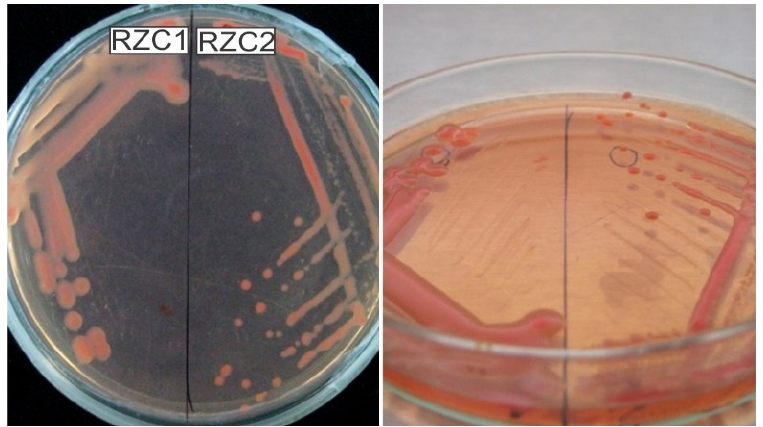
Figure 2. ( Left ): Isolation plate where the strain RZC1 is clearly differentiated from the strain RZC2. ( Right ): Convex elevation and pink color of rhizobial strains.